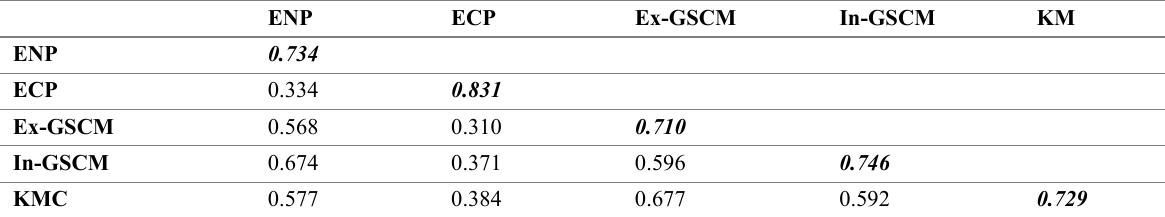
Table 4: Discriminant Validity (Fornell-Larcker